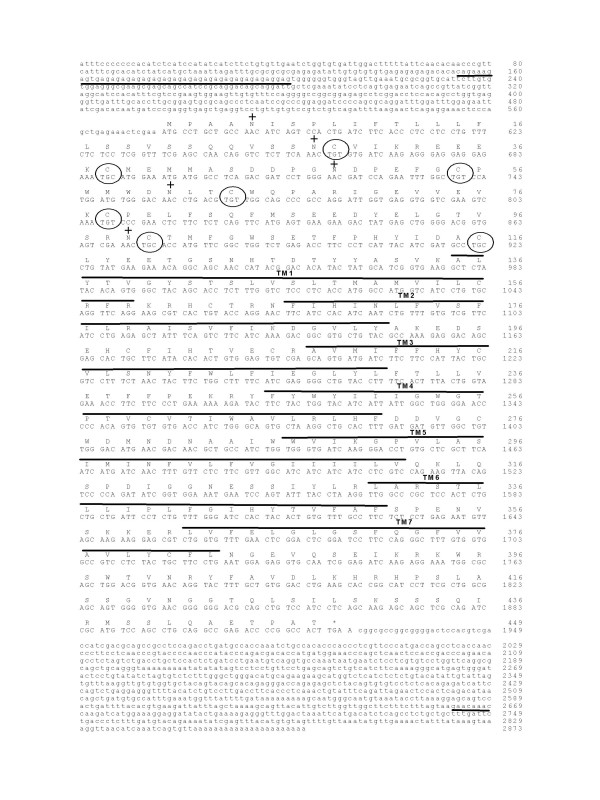
Nucleotide and predicted protein sequence of sbPAC1B receptor. The seven TM domains are highlighted with black lines and the conserved N-terminal cysteine residues and putative N-glycosylation sites are annotated respectively by a circle and by "+". The microsatellite identified in the 5'UTR is underlined and stop codon is indicated by "*".